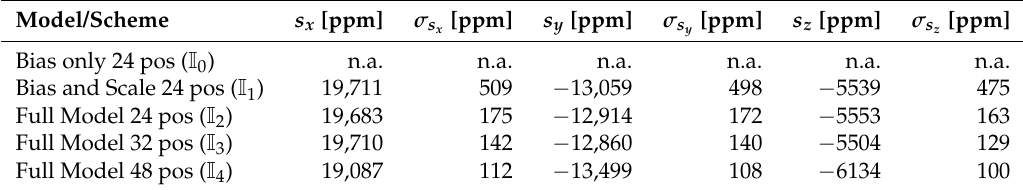
Table 3. Estimated scale factor of IMU